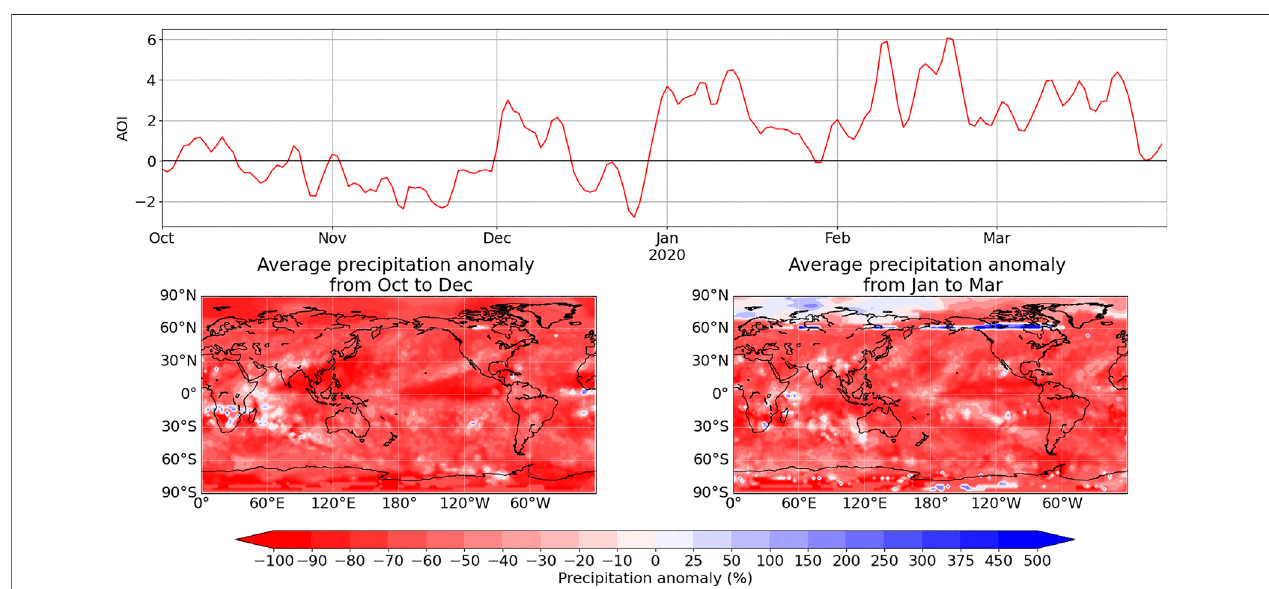
FIGURE 11 | (A) AOI from October 1, 2019, to March 31, 2020. (B) Average global precipitation anomaly from October to December. (C) Average global precipitation anomaly from January to